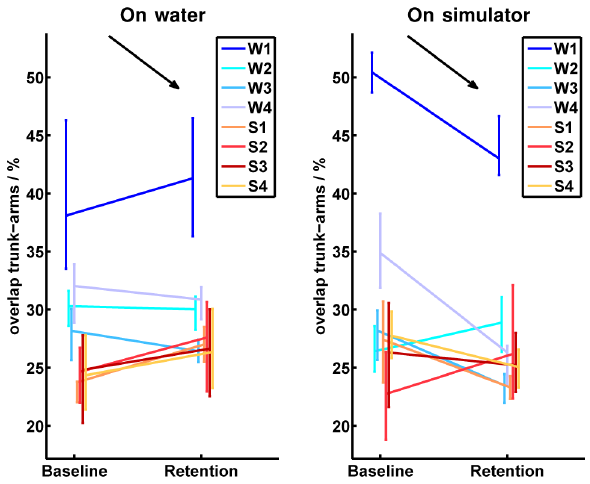
Figure 11. Absolute values of the depth of blade immersion. The left half image shows the development of all participants from baseline to retention tests on water, while the right half image illustrates the baseline and retention measurements on the simulator. Participants of the on-water group are indicated by bluish colors and abbreviated by W 1 to W 4 in the legend. Participants of the simulator group are indicated by reddish colors and abbreviated by S 1 to S 4 in the legend. The vertical bars in the baseline and retention tests cover all values performed by the corresponding participant. The measured values in the baseline and the retention tests are connected in the mean values for each participant. The black arrow indicates the direction of the desired development from baseline to retention in the corresponding test environment. In general, the oars should be just fully immersed. In the simulator, the oars were completely immersed at a depth of blade of 5 : 84 0 . On water, the depth of blade depended on the rower’s weight, balance, and the waves. However, due to differences in rigging between the measurements on water and on the simulator, the oars were completely immersed on water at a depth of blade around 11 0 .